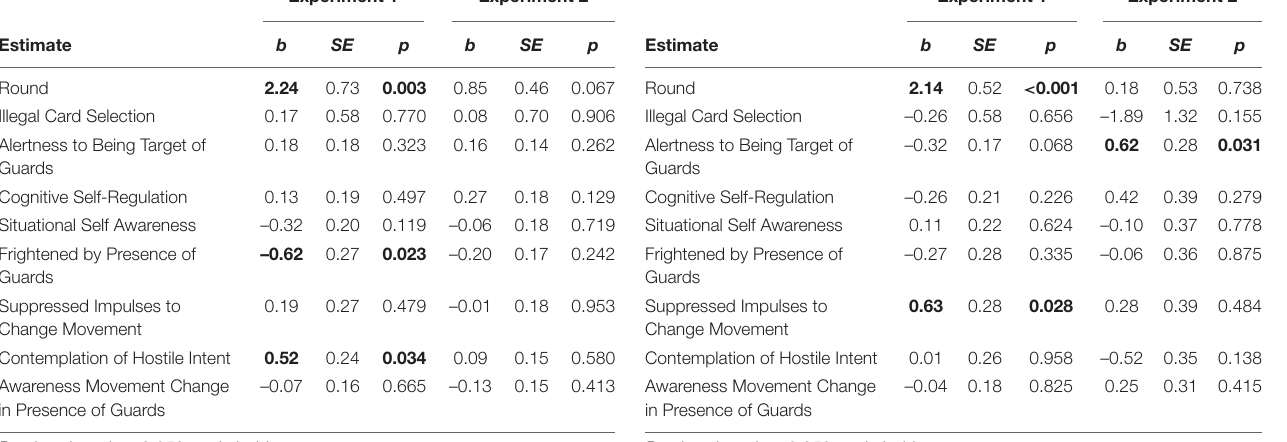
TABLE 4 | Regression beta, SE, and P -values for intra-team distance as dependent variable. Experiment 1